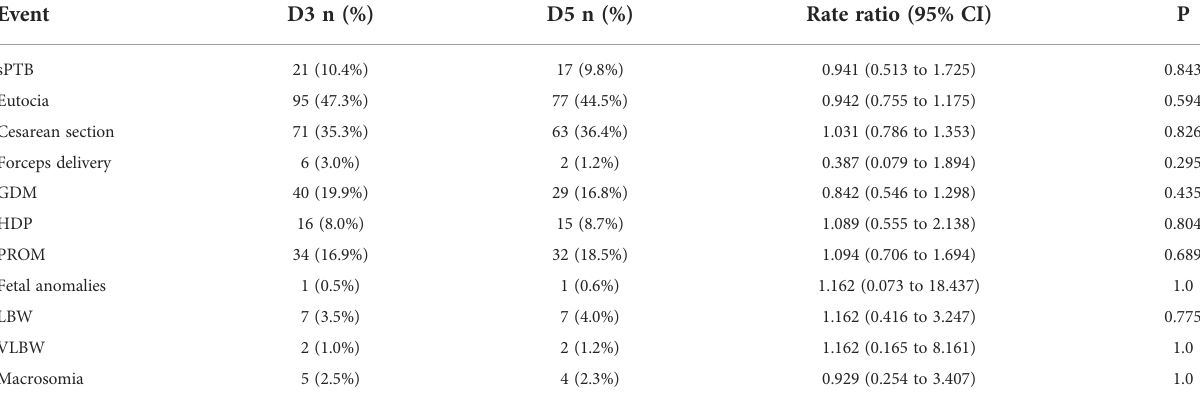
TABLE 4 Adverse